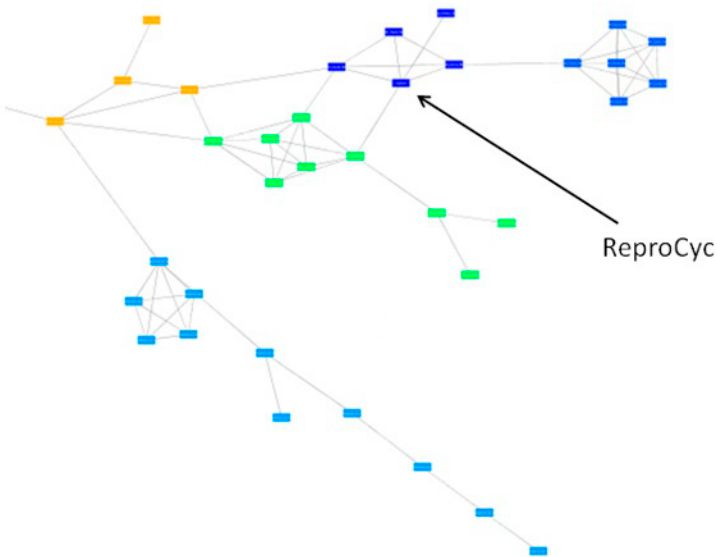
Figure 5. Genetic stability of ReproCyc PRRSV vaccine using the similarity network approach .